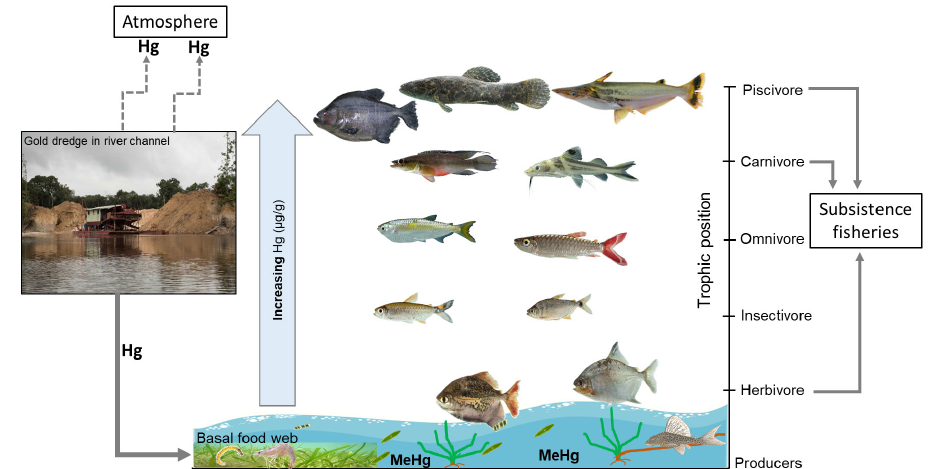
FIGURE 1 | Conceptual model of how Hg enters riverine food webs of the Mazaruni River, Guyana. First, artisanal gold mining operations installed in the river use a suction dredge to reach gold contained in bottom sediments. These mining operations use mercury for gold amalgamation of which the majority is lost to the atmosphere or river. Once in the river, Hg can be methylated by microbes into the toxic Methylmercury (MeHg) and be assimilated rapidly by aquatic biota. Hg concentration bioaccumulates and biomagnifies in the trophic food chain. Fishes at higher trophic levels [piscivores and carnivores ( e.g ., piranhas, aimaras, and catfishes)] are important items in the diet of local communities and can become a direct source of Hg uptake via direct